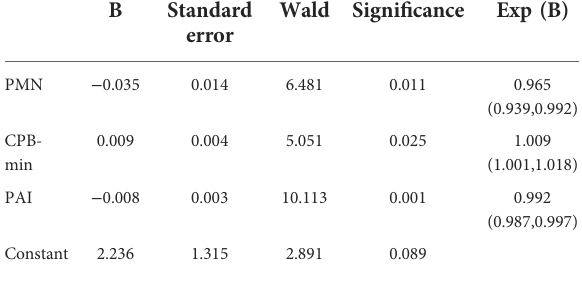
TABLE 2 Regression equationg for SLI after TOF